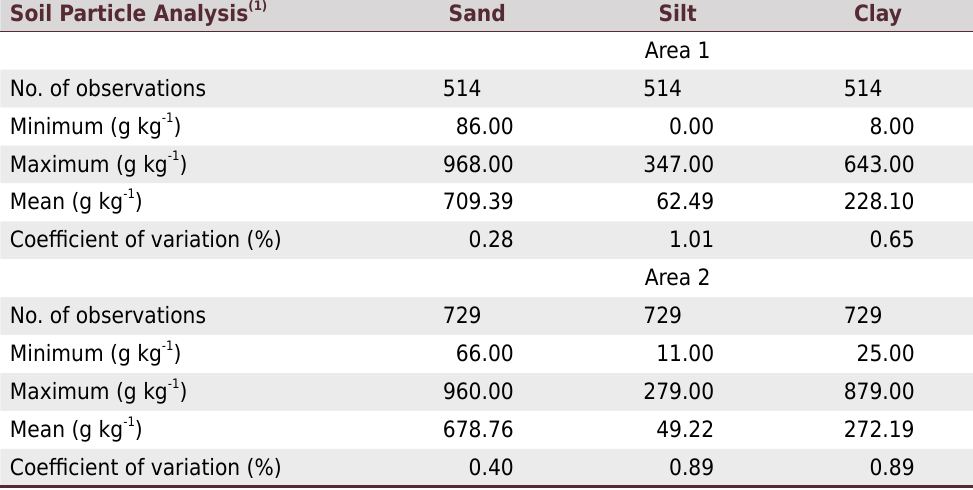
Table 1. Descriptive statistics of soil contents of clay, sand, and silt in Area 1 and